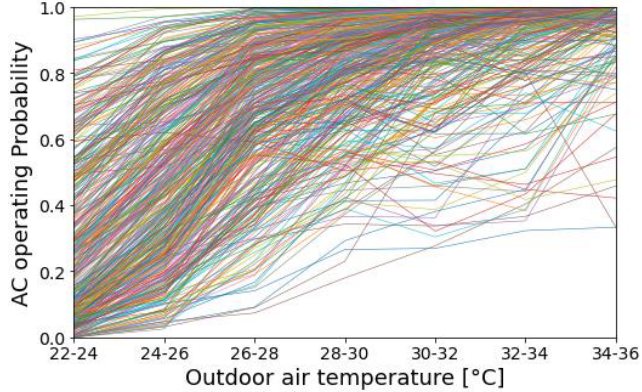
Figure 8. AC operating probability in different outdoor air temperature ranges for all 486 dwellings [10].